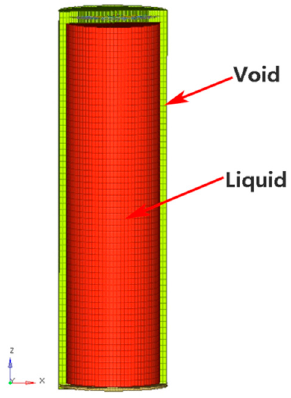
Figure 6. The image of the model of fluid components.